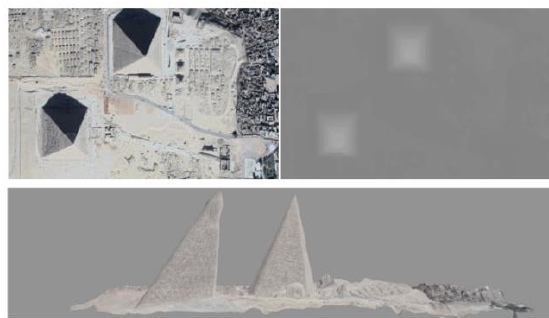
Figure 4 . Comparison of reconstruction space between original orthoimage (orange) and GE (green) image in Washington, DC (DC GIS Group, 2021). The red points are the matching vertices of two